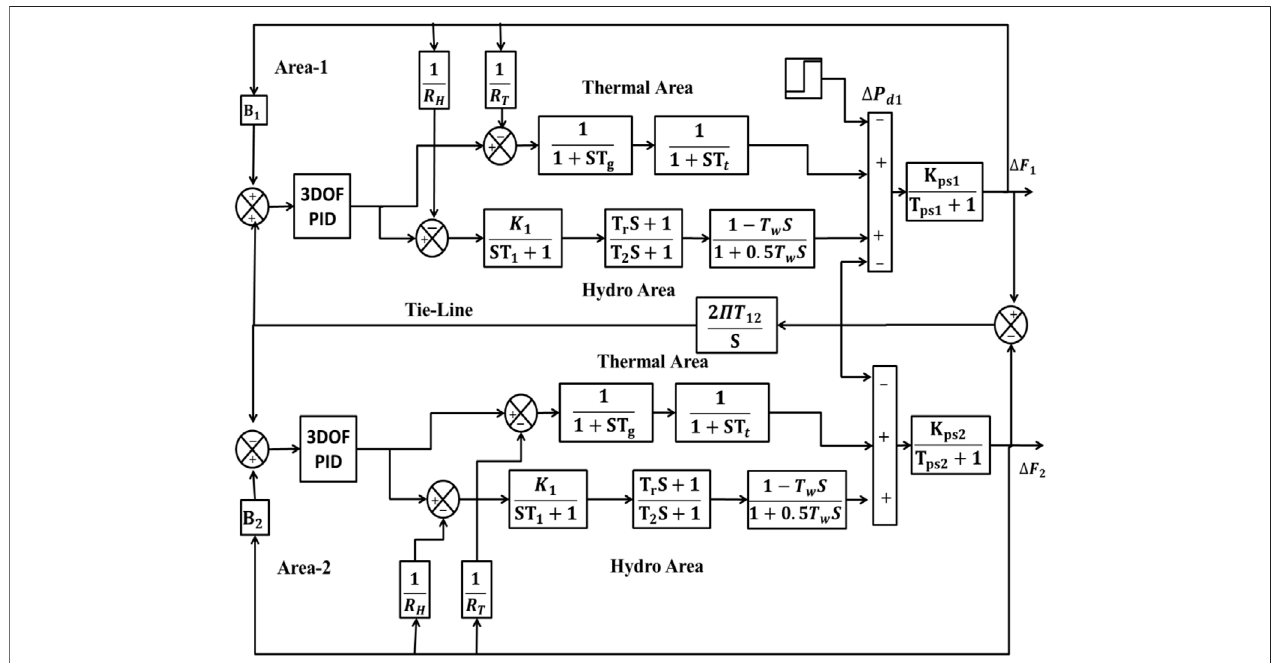
FIGURE 1 | Model of the DAHT power system (Goud et al.,